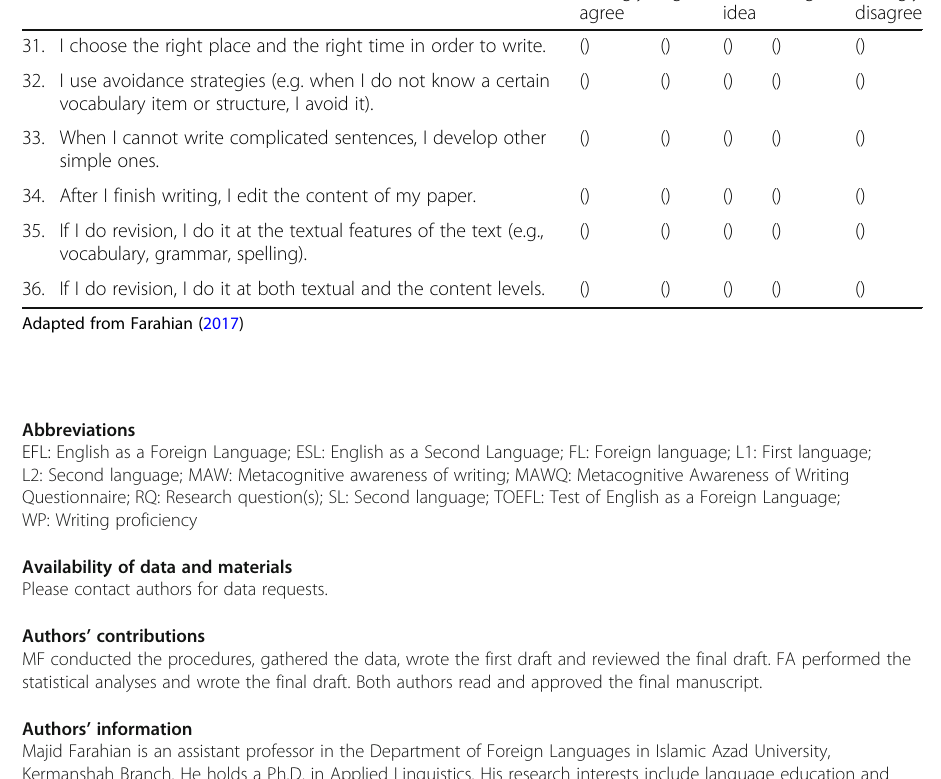
Agree No Disagree Strongly agree idea disagree